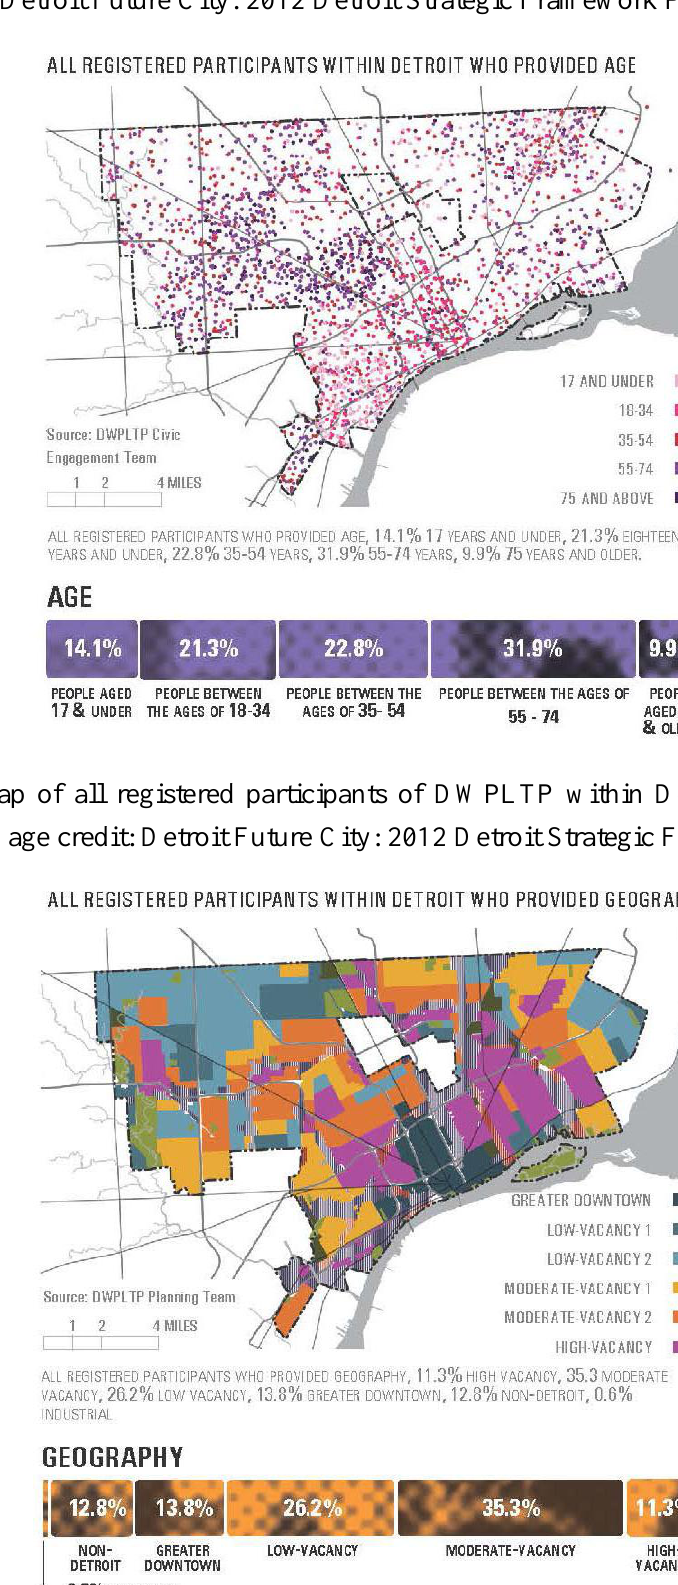
Figure 9. Map of all registered participants of DWPLTP within Detroit who provided age. (Image credit: Detroit Future City: 2012 Detroit Strategic Framework Plan).